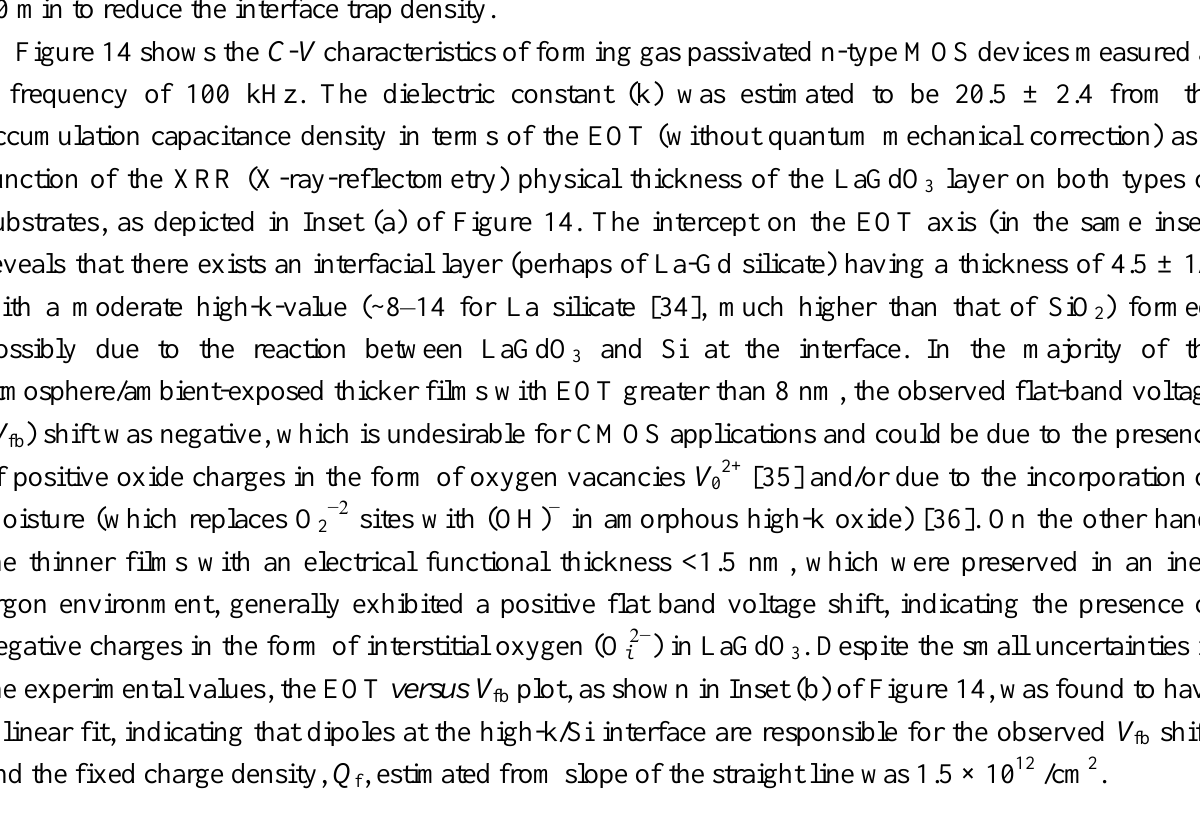
/Si(111) gate stacks with 3